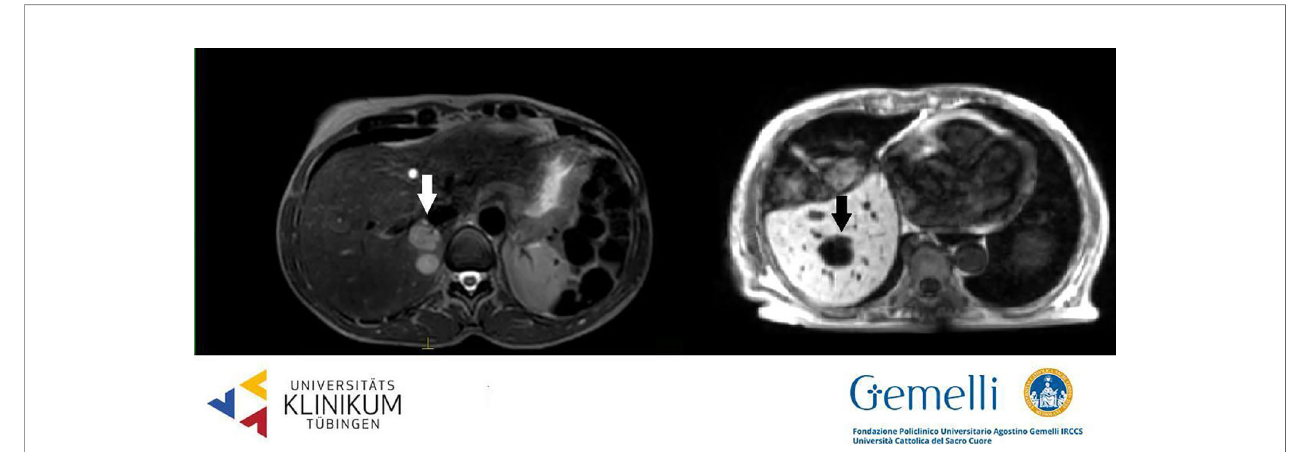
FIGURE 2 | Liver secondary lesions on T2 weighted 1.5 T hybrid imaging (left, hyperintense, from breast cancer) and on T1 weighted 0.35 T hybrid imaging (right, hypointense, from gastric